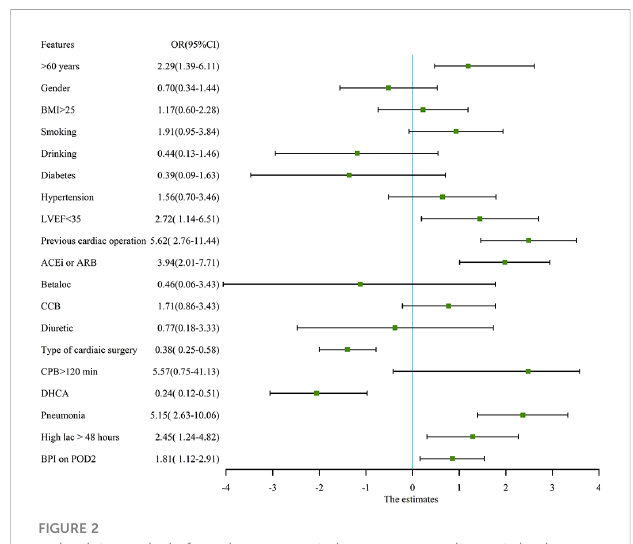
FIGURE 2 univariate analysis for adverse events in pre-propensity matched patients. The fi gure applied log2 transformation in order to make it easy to read. BMI, Body mass index; LVEF, Left ventricular ejection fraction; ACEi, Angiotensin-converting enzyme inhibitors; ARB, Angiotensin receptor blockers; CCB, Calcium channel blocker; CPB, Cardiopulmonary bypass; DHCA, Deep hypothermic circulation arrest; Betaloc, b -blocker; BPI, Bilateral pulmonary in fi ltrates on chest X